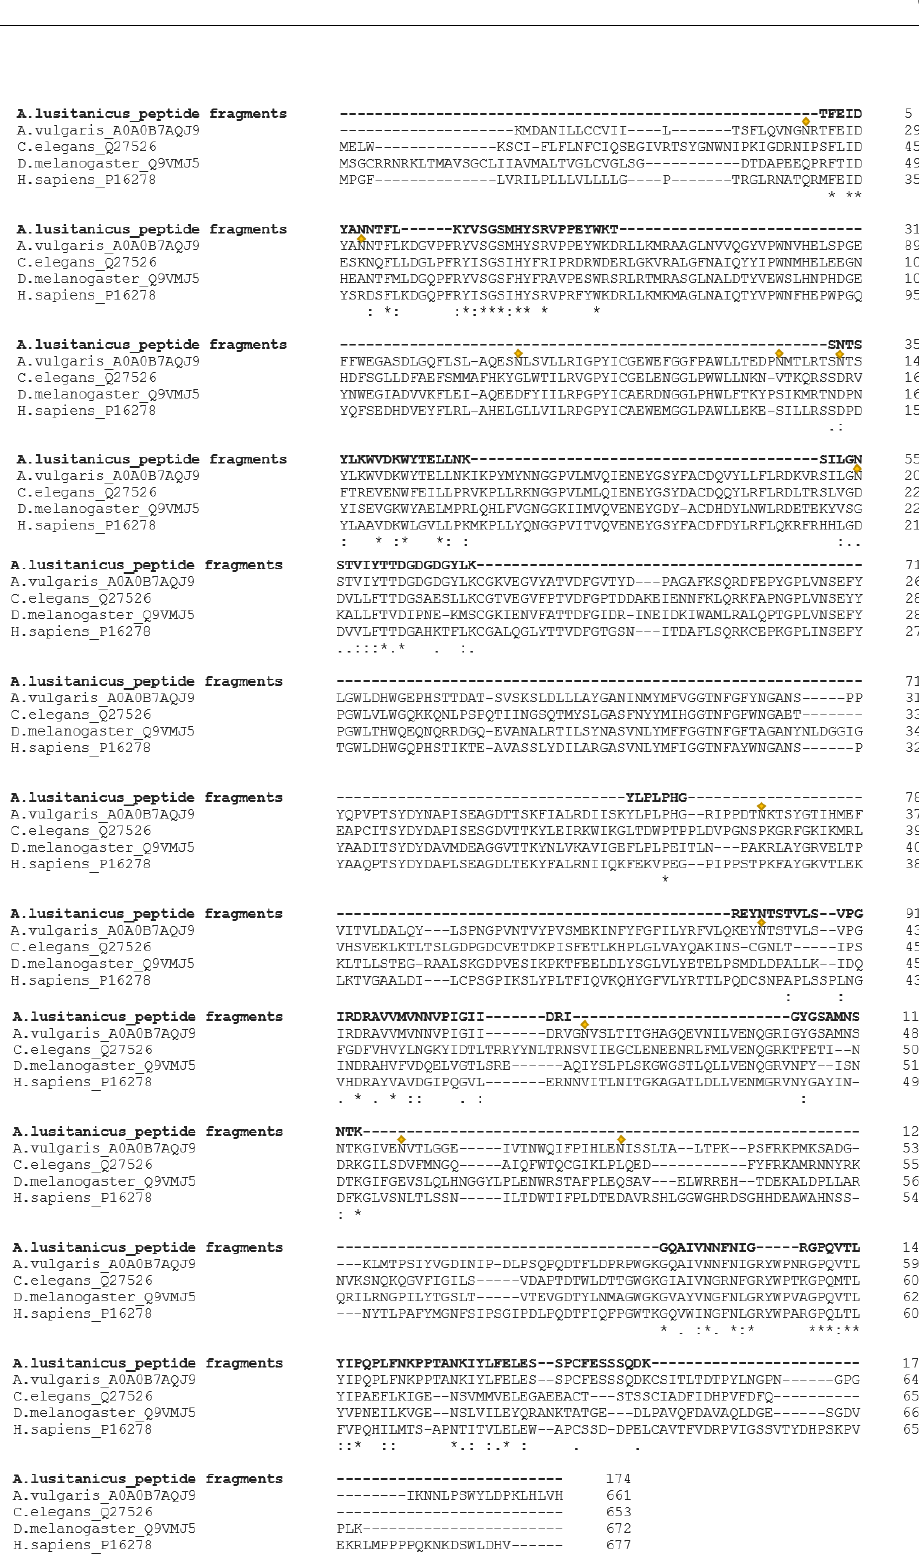
Figure 1. Peptides found in A. lusitanicus aligned to active β -galactosidase from Homo sapiens (P16278), D. melanogaster (Q9VMJ5), C. elegans (Q27526), and putative β -galactosidase from A. vulgaris (A0A0B7AQJ9). Yellow rhomb indicates putative N-glycosylation sites in Arion vulgaris according to the N-X-S/T consensus sequence. (*) marks identical amino acid residues, (:) related amino acid residues, and (.) predominantly the same amino acid